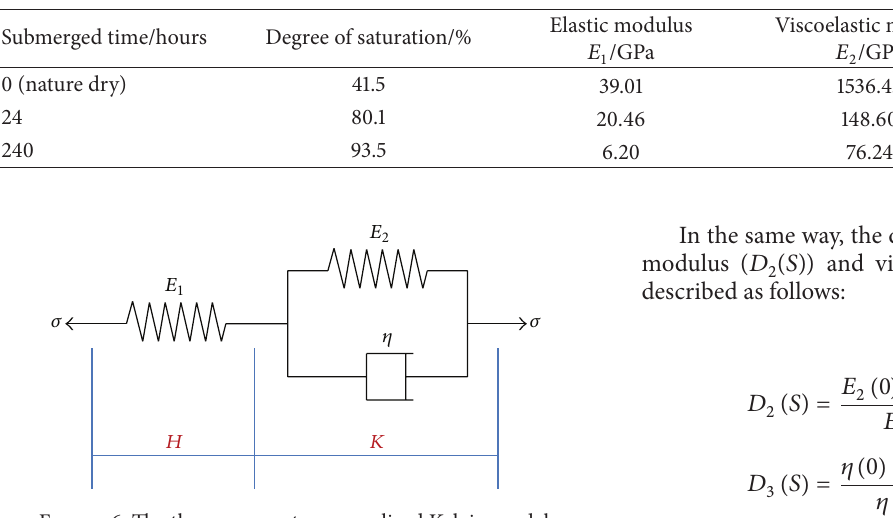
Table 2: Creep parameters of specimens with different moisture contents.